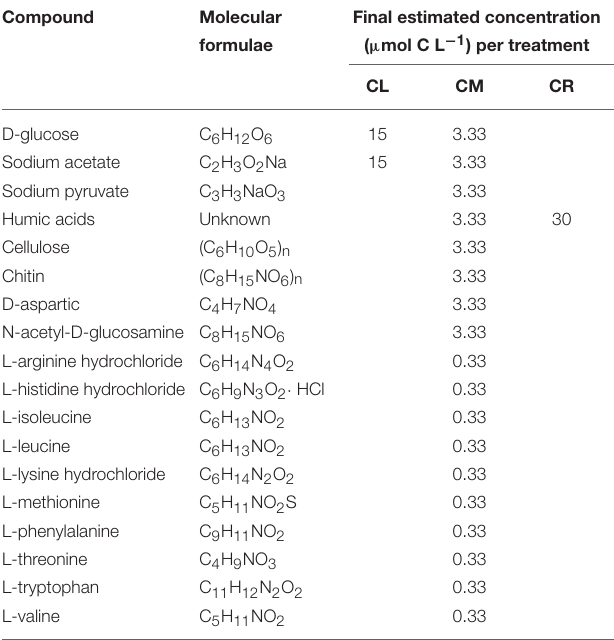
TABLE 1 | A list of the compounds added to each experimental treatment (Sigma-Aldrich Co.